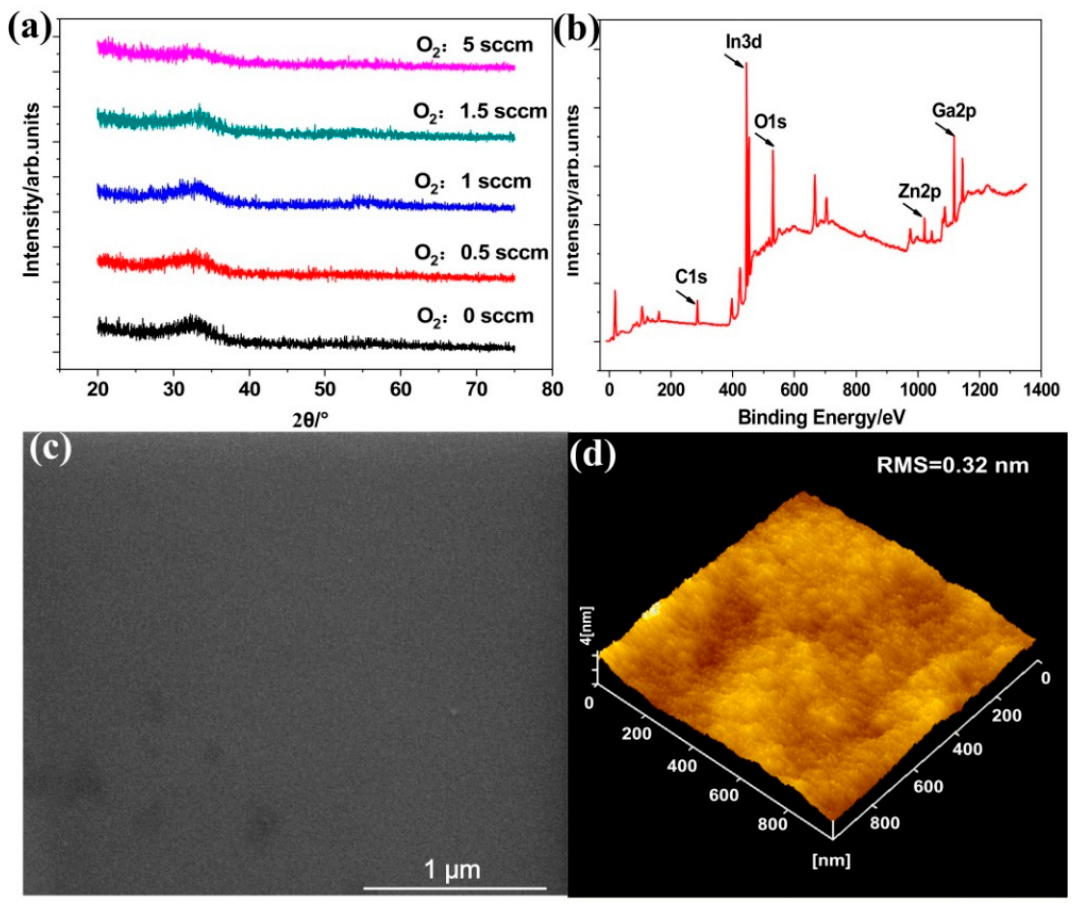
Figure 2. The microscopic characteristics of a-IGZO film. ( a ) XRD; ( b ) XPS; ( c ) SEM; ( d ) AFM. Table 2. The metal atoms ratio of a-IGZO films sputtered at room temperature. Elements